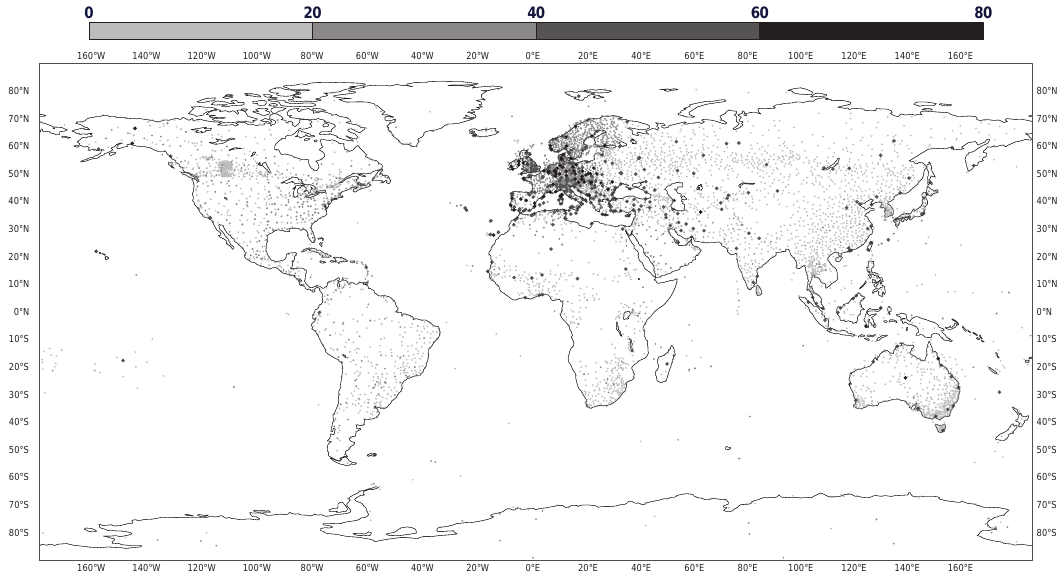
Figure 7. Number of SYNOP T from 1 to 15 July 2012. The size of each dot is proportional to the number of observations per model grid